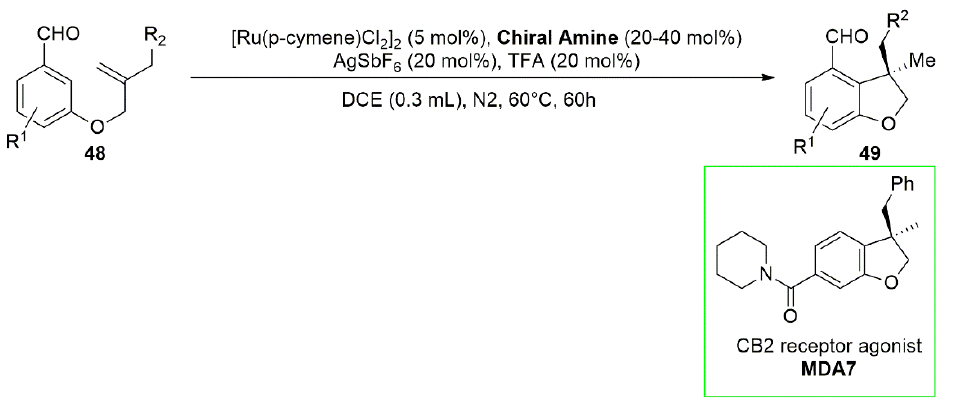
Figure 25 . Enantioselective synthesis of chiral 3,3-disubstituted 2,3-dihydrobenzofurans ( 49 ) by ruthenium(II) – chiral amine systems.